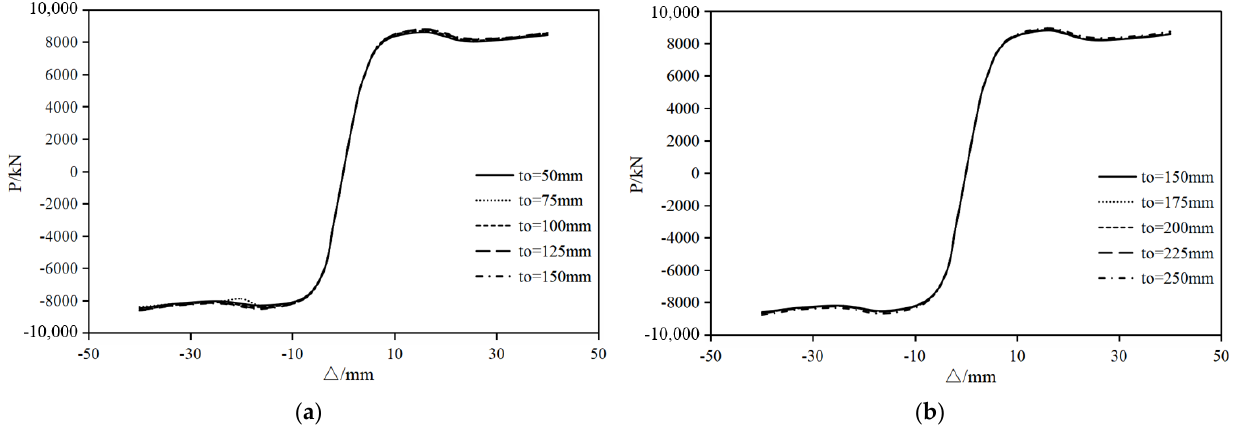
Figure 8. Hysteresis curve of models with different lap lengths. ( a ) l o = 50 mm; ( b ) l o = 75 mm; ( c ) l o = 100 mm; ( d ) l o = 125 mm; ( e ) l o = 150 mm; ( f ) l o = 175 mm; ( g ) l o = 200 mm; ( h ) l o = 225 mm; ( i ) l o = 250 mm.